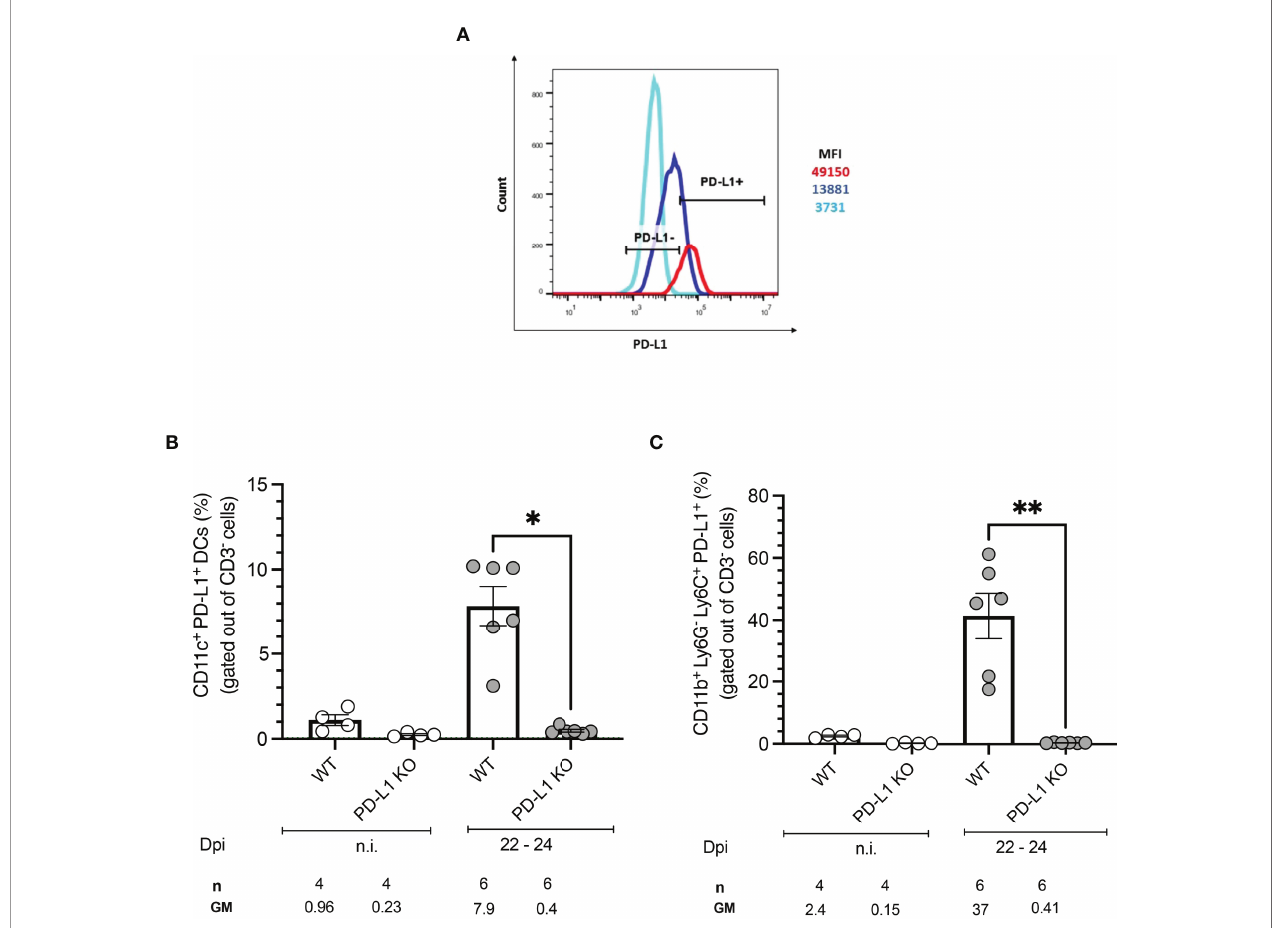
FIGURE 1 | PD-L1 expression on antigen-presenting cells after in vitro and in vivo infection with T. cruzi. BMDCs were infected with T. cruzi in vitro. After 72 h the PD-L1 Expression was analyzed by fl ow cytometry. (A) The Histogram shows the MFI of PD-L1 expression on infected (red) and non-infected (blue) BMDCs. FMO staining control (light blue) was used to identify and gate the PD-L1cells population. Expression of PD-L1 on APCs from WT and PD-L1 KO mice infected with T. cruzi. On day 22- 24 post-infection spleens from infected and n.i. mice were isolated and the expression of PD-L1 was evaluated by fl ow cytometry. (B) Expression of PD-L1 on CD11b - CD11c + (DCs). (C) Expression of PD-L1 on CD11b + Ly6G - Ly6C + M F . Data shown are corresponding to two independent experiments n.i. = 4; infected =6. Asterisks denote P values of <0.05. *P<0.05 and